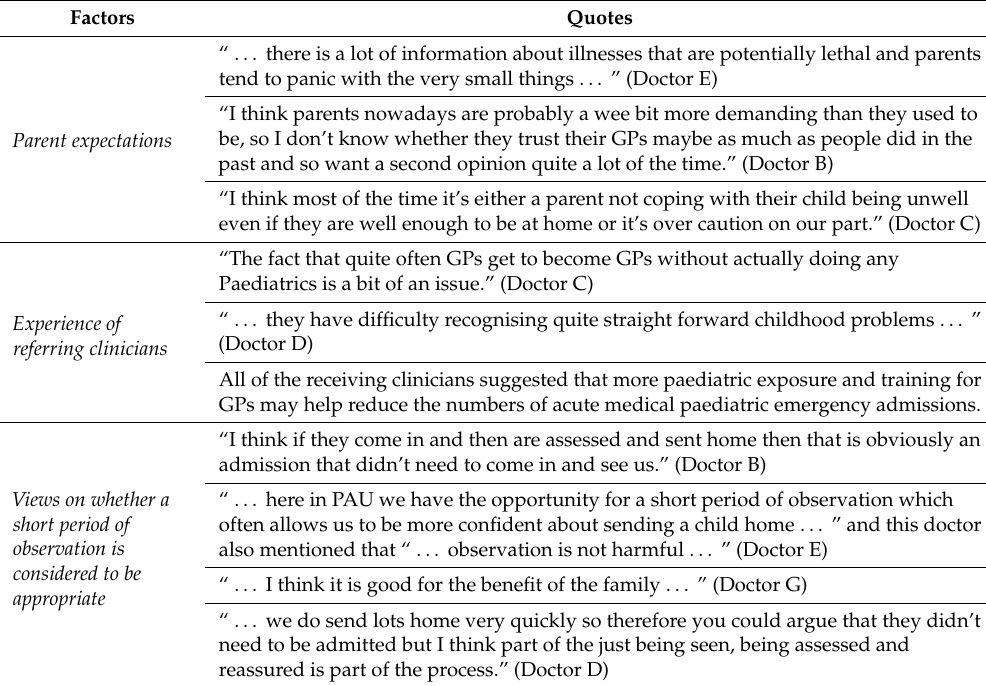
Table 3. Quotes from receiving clinicians relating to some of the factors which they believe may influence parents and referring clinician’s decision to refer a child to hospital with an acute medical